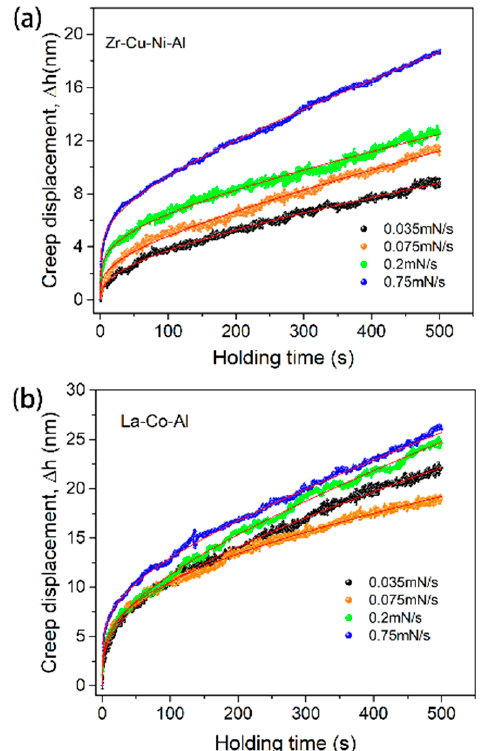
Figure 7. Typical creep displacements versus holding time with four different loading rates at the initial holding depth of 200 nm for ( a ) Zr-Cu-Ni-Al and ( b ) La-Co-Al; the creep curves could be perfectly fitted.